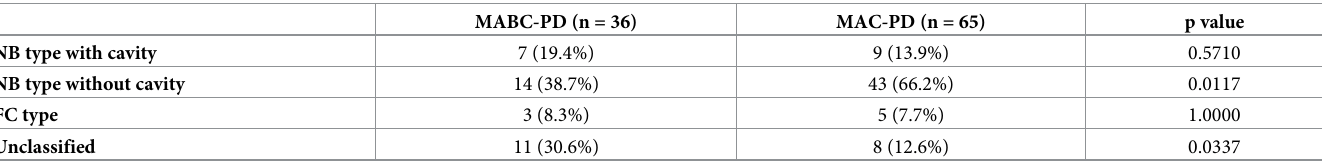
Table 2. General classification of the imaging